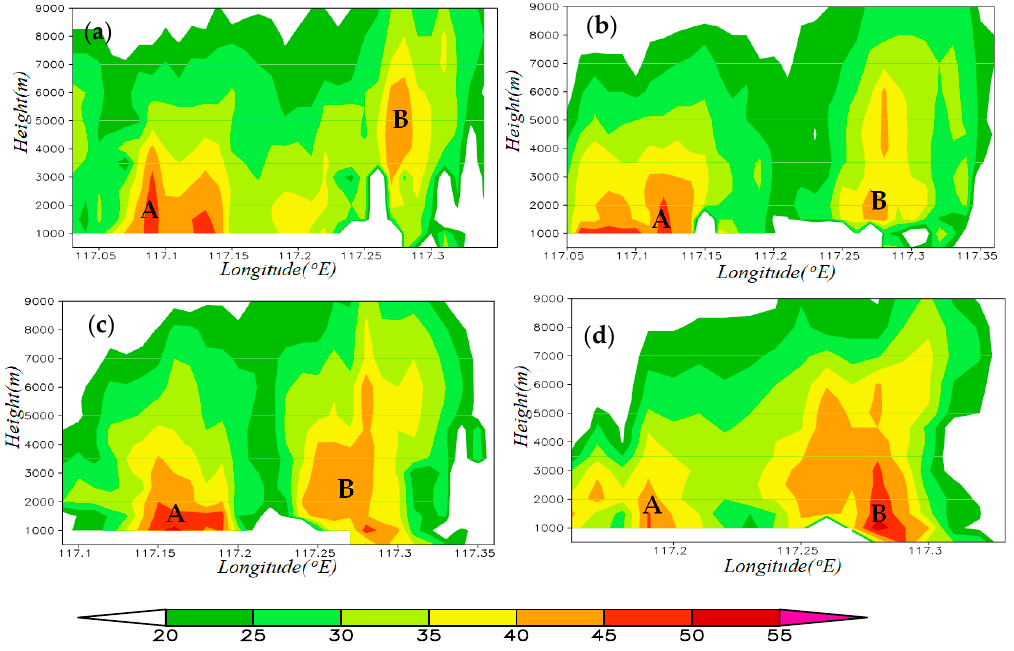
Figure 10. Cross section of reflectivity (colored, unit: dBZ) along the solid lines in Figure 10: ( a ) 19:06, ( b ) 19:12, ( c ) 19:18 and ( d ) 19:24 BT on 1 August 2019. “A” and “B” represent the position of two convections.